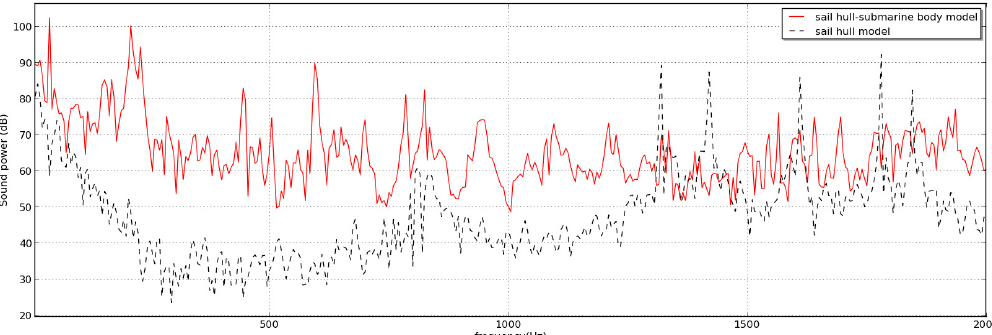
Figure 17. Comparison between the sound radiation power from the sail hull in our study and the isolated sail hull. The red line denotes the sound radiation power from the sail hull in this research. The black dotted line denotes the sound radiation power from the isolated sail hull.